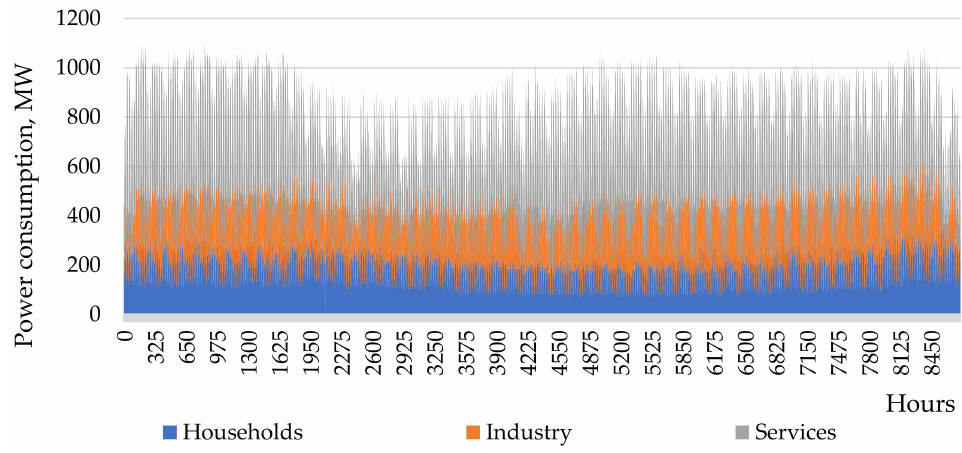
Figure 4. Hourly power consumption by consumer type.